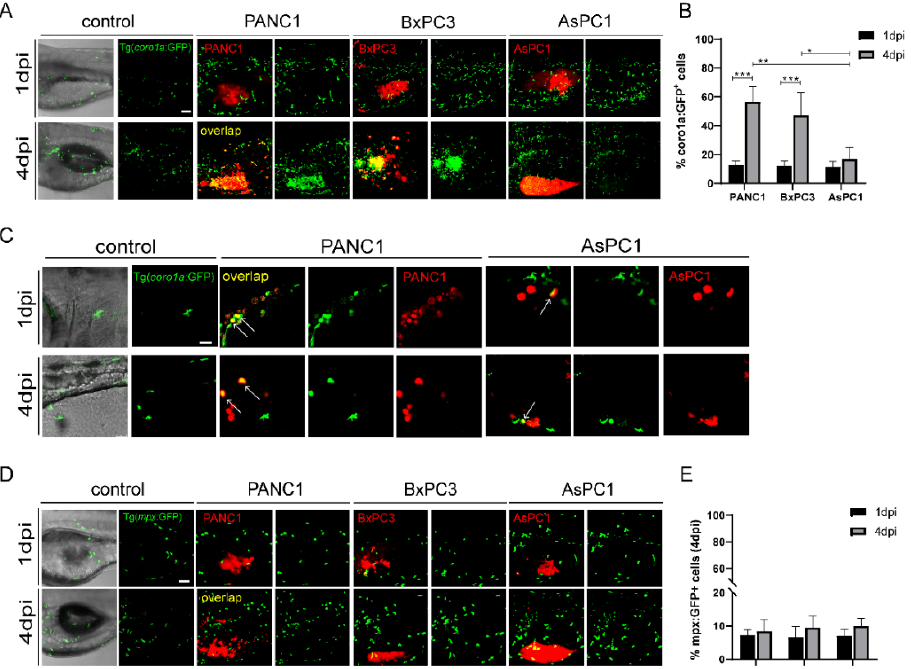
Figure 2. The pancreatic cancer cells show distinct interaction with the innate immune cells in zebrafish. ( A ) Representative confocal images of Tg( coro1a: GFP )-labeled innate immune cells in PANC1, BxPC3, and AsPC1 xenografts at 1 dpi and 4 dpi. ( B ) Qualification of innate immune cell percentage in PANC1, BxPC3, and AsPC1 cells at 1 dpi and 4 dpi (no. of innate immune cells/no. of tumor cells × 100). Results are shown as means ± SEM from nine different individuals (* p < 0.05, ** p < 0.01, *** p < 0.001, ANOVA). ( C ) Enlarged confocal images of innate immune cells co-localized with PANC1 and AsPC1 xenografts at 1 dpi and 4 dpi. Arrows point to the co-localized cells. ( D ) Representative confocal images of Tg( mpx: GFP )-labeled neutrophils in PANC1, BxPC3, and AsPC1 xenografts at 1 dpi and 4 dpi. ( E ) Qualification of neutrophils percentage in PANC1, BxPC3, and AsPC1 cells at 1 dpi and 4 dpi (no. of neutrophils/no. of tumor cells × 100). Results are from nine different individuals. dpi, days post injection. Scale bars in ( A , D ), 50 µm; in ( C ), 25 µm.